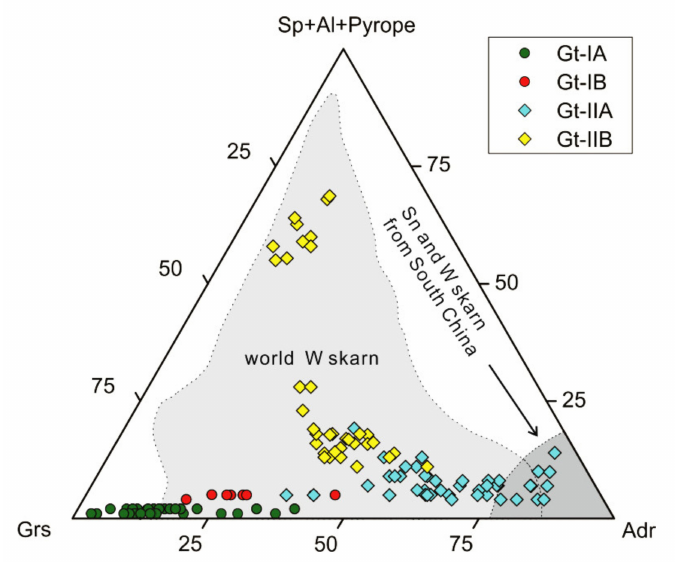
Figure 5. Ternary plots of the garnet compositions from the Zhuxiling W (Mo) deposit. The ranges of garnets in W / Sn skarn around the world are from [1] and the data for Sn and W skarn in South China are from